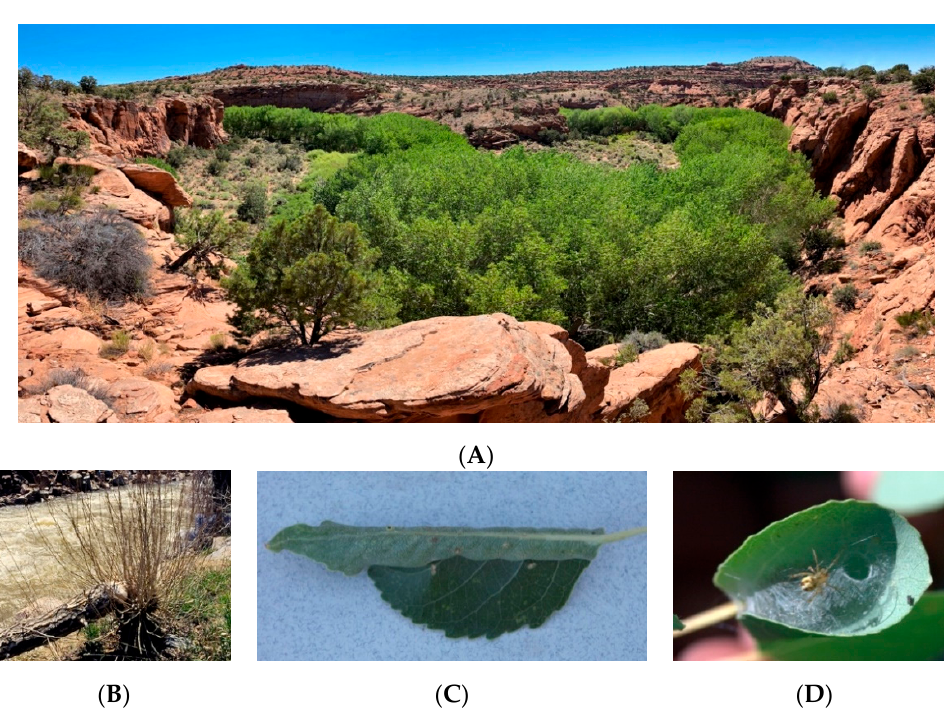
Figure 1. ( A ) Riparian “ribbon of green” of P. fremontii near Moab, UT; ( B ) Resprout growth of P. angustifolia after felling by beavers; ( C ) Leaf rolling moth ( Anacampsis niveopulvella Chambers, 1875; an indicator species of resprout growth after P. fremontii felling by beavers); ( D ) Leaf rolling moth larvae, a member of the arthropod community influenced by beaver herbivory, in the family Tortricidae (also indicator species of resprout growth) create habitat for other arthropods, such as this spider.